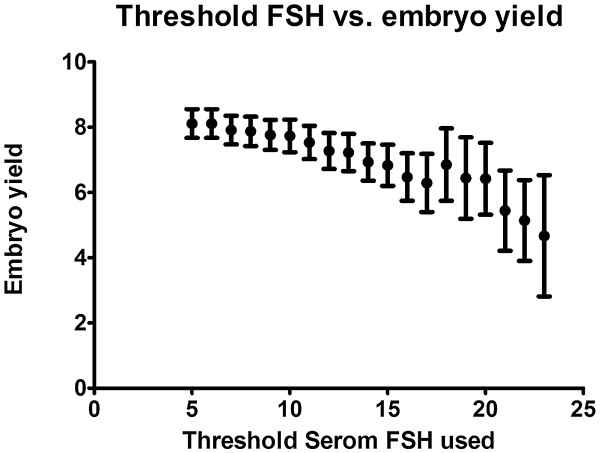
CD7 FSH and embryo yield. Embryo yields with different thresholds of serum FSH on CD7 to define a high level starting with a threshold of > 5 IU/L until 30 IU/L. Error bars indicate the standard error of the mean.